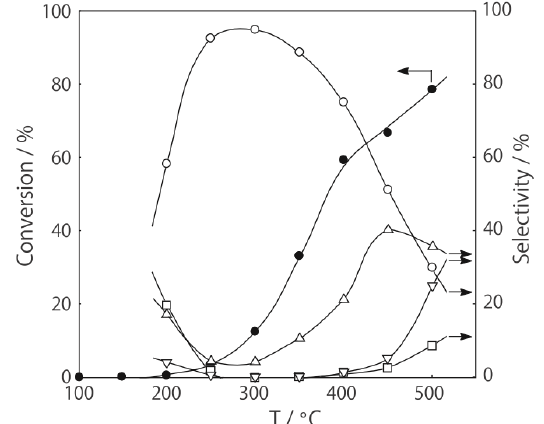
Figure 16. Effect of temperature on the reaction of piperidine with methanol over (H O) [(W Cl )Cl ]·6H O/SiO . Following the activation of the supported cluster (30 mg, 3 2 6 8 6 2 2 0.86 μmol) in a hydrogen stream (600 mL/h) for 1 h, reaction was initiated by introduction of piperidine (99 μL/h, 1.0 mmol/h) and methanol (41 μL/h, 1.0 mmol/h) to the stream without changing the temperature. Conversion and selectivities are based on piperidine